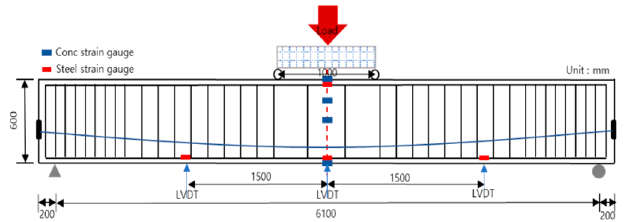
Figure 4. Flexural test setup (using a concrete strain gauge, steel strain gauge, and a linear variable differential transformer).